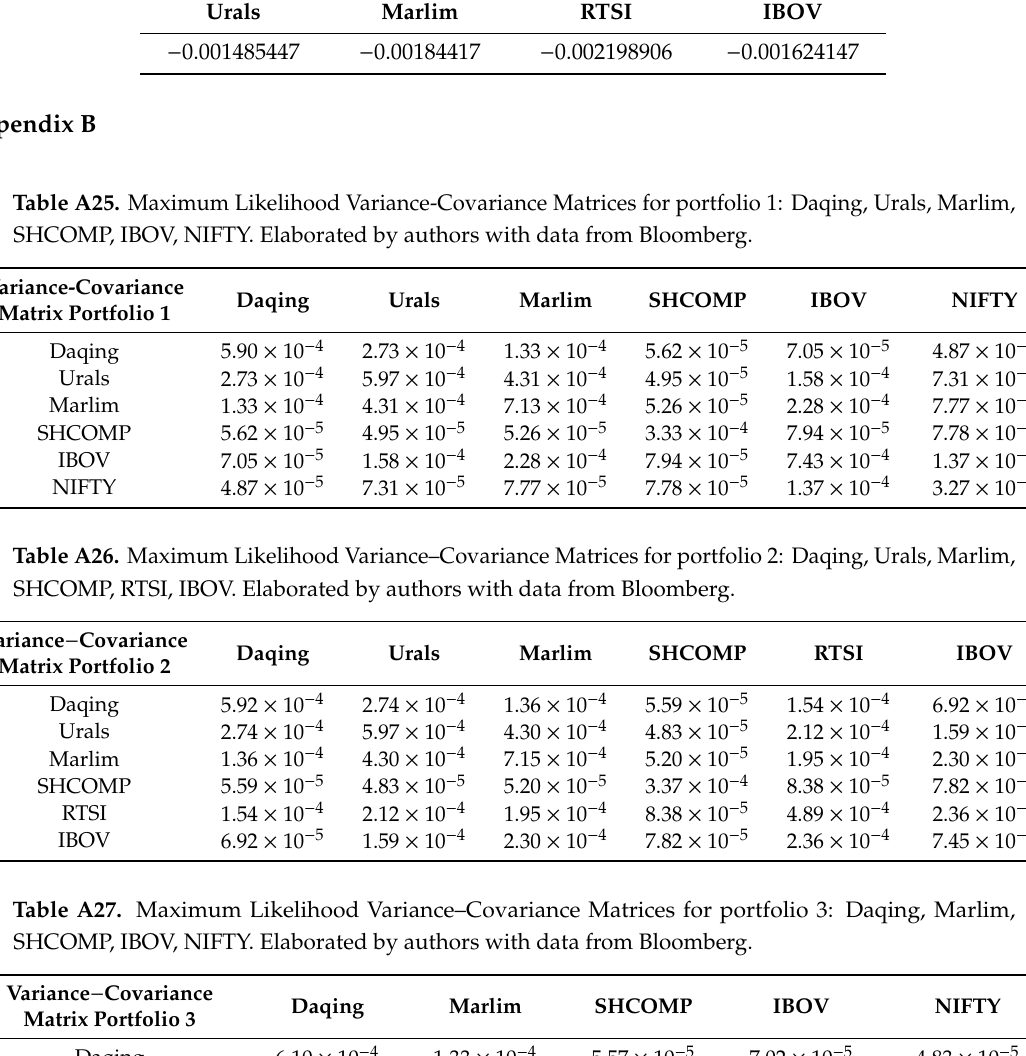
Table A24. MNIG Skewness parameter γ for Vector 6: Urals, Marlim, RTSI, IBOV. γ (Skewness Parameter)